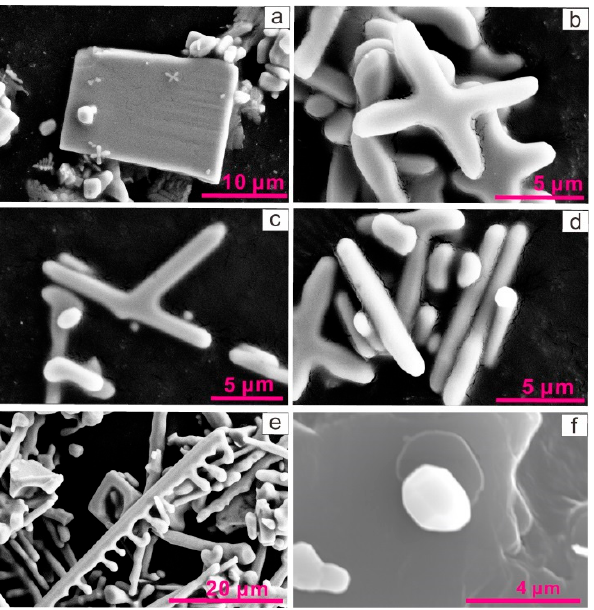
Figure 2. Scanning electron microscope (SEM) images of barite synthesized by in situ mixing of Na 2 SO 4 and BaCl 2 solutions at 200 °C. ( a ) plate-shaped ( b ) X-shaped ( c ) T-shaped ( d ) rod-shaped ( e ) dendritic ( f ) granular. Table 2. The morphological statistics of barite appearing in a mixed solution of barium salt and sulfate with different ratios at 200 °C. Morphology of Barite Synthetic Solution Mixing Ratio (Molar Condition Ratio of Na 2 SO 4 to BaCl 2 ) Rod-Shaped Granular Plate-Shaped Dendritic X-Shaped T-Shaped 0.03 mol/kg Na 2 SO 4 and BaCl 2 + Note: “+” indicates existence and “-” indicates absence. At concentrations of Na 2 SO 4 and BaCl 2 solutions of 0.03 mol/kg, rod-shaped, granu- lar, X-shaped, and T-shaped crystals appeared in all mixing ratios, while plate-shaped crystals appeared in the mixes of 1:1, 3:7, and 2:8 and dendritic shapes only appeared in mixes of 2:8. In addition, at concentrations of Na 2 SO 4 and BaCl 2 of 0.1 mol/kg, rod-shaped, granular, X-shaped, and T-shaped crystals appeared in all 5 mixing proportions, while plate-shaped crystals appeared in the mixes of 1:1, 3:7, and 2:8, and dendritic appeared in the mixes of 3:7 and 2:8. The histograms of the barite particle size synthesized in mixes of 0.03 mol/kg Na 2 SO 4 and BaCl 2 with a ratio of 2:8 at 200 °C are shown in Figure 3. The plate-shaped barite with a particle size of 4.0–6.0 μ m accounts for about 42% of the total, the rod-shaped barite with a particle size of 1.0–1.5 μ m accounts for about 18% of the total, the granular barite with a particle size of 2.0–2.5 μ m accounts for about 39% of the total, the dendritic barites with a